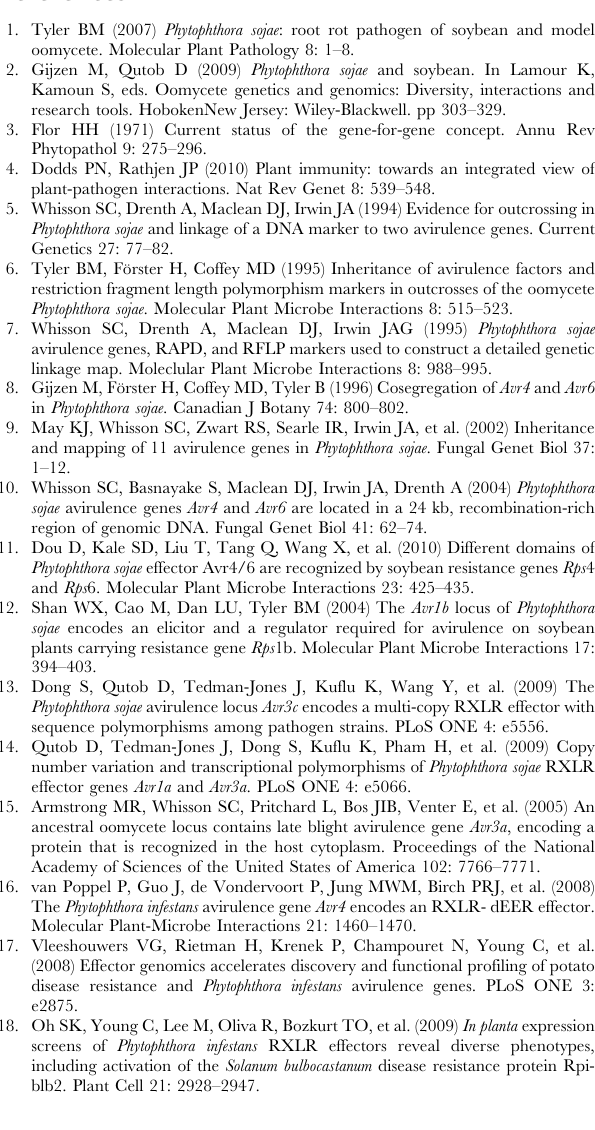
Table S1 List of P.sojae strains used in this study. (DOC) Table S2 Oligonucleotide primers used in this study. (DOC) Figure S1 Comparison of the Avr3a structural gene in P. sojae strains P6497, P7064, and ACR12, illustrating promoter region insertions and deletions. Figure S2 Representative photographs from co-bom- bardment and virulence assays performed on soybean plants. (A) Photographs of soybean L85–3059 ( Rps 5) leaves, after co-bombardment of GUS reporter together with control plasmid or selected Avr3a alleles. Numbers in parenthesis indicate total GUS positive spots counted for each treatment, in this experiment (B) Photographs of light-grown soybean plants after